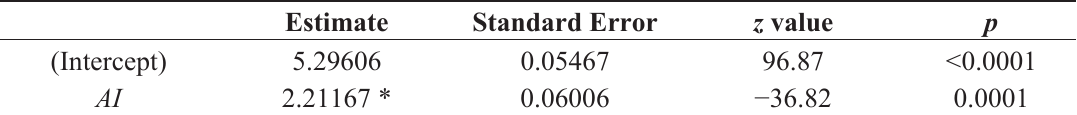
Table 2. Results from negative binomial regression for predicting beetle occupancy based on the aggregation index in 2006. * Coefficient estimate is adjusted to account for the use of inverse counts in the regression model. Adjustment was made by multiplying the coefficient estimate by (cid:237)